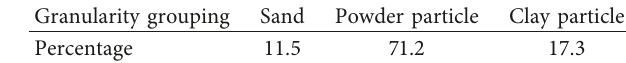
Table 3: Grading of undisturbed